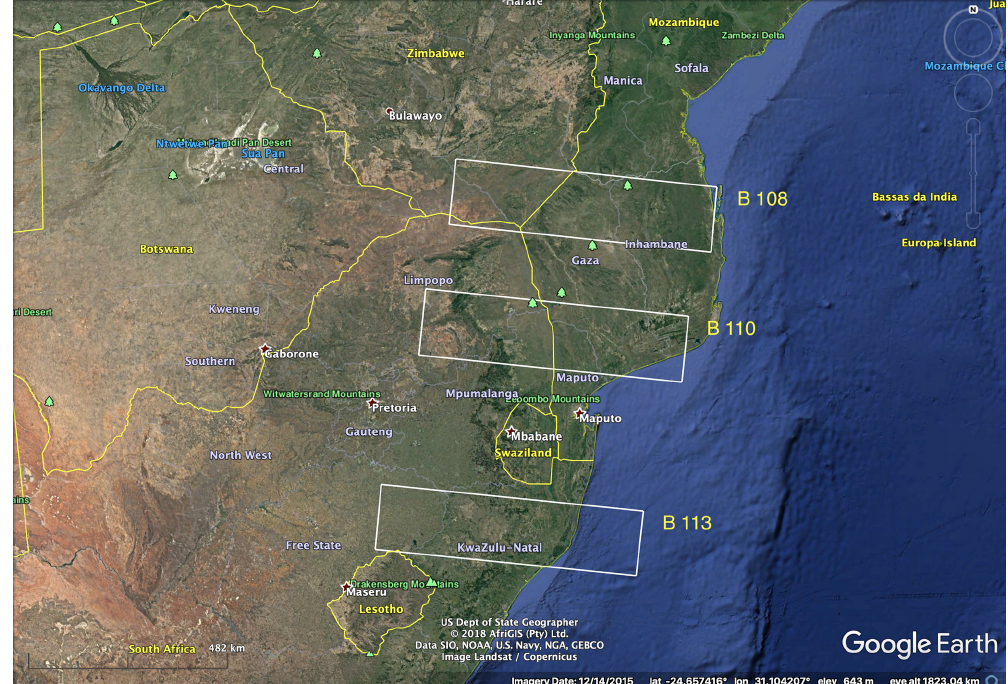
Figure 2. Google Earth Pro (Version 7.3.2.5776, 64bit, 5 March 2019) map of southern Africa showing the geographical location of the three MISR Blocks mentioned in the text and in the figures of Sects. 2 to 4. Approximate NW corner: 17.0 ◦ S, 20.5 ◦ E; SE corner: 31.0 ◦ S, 44.0 ◦ E; eye altitude: 1823km; data from SIO, NOAA, US Navy, NGA and GEBCO and imagery from Landsat–Copernicus. © Google